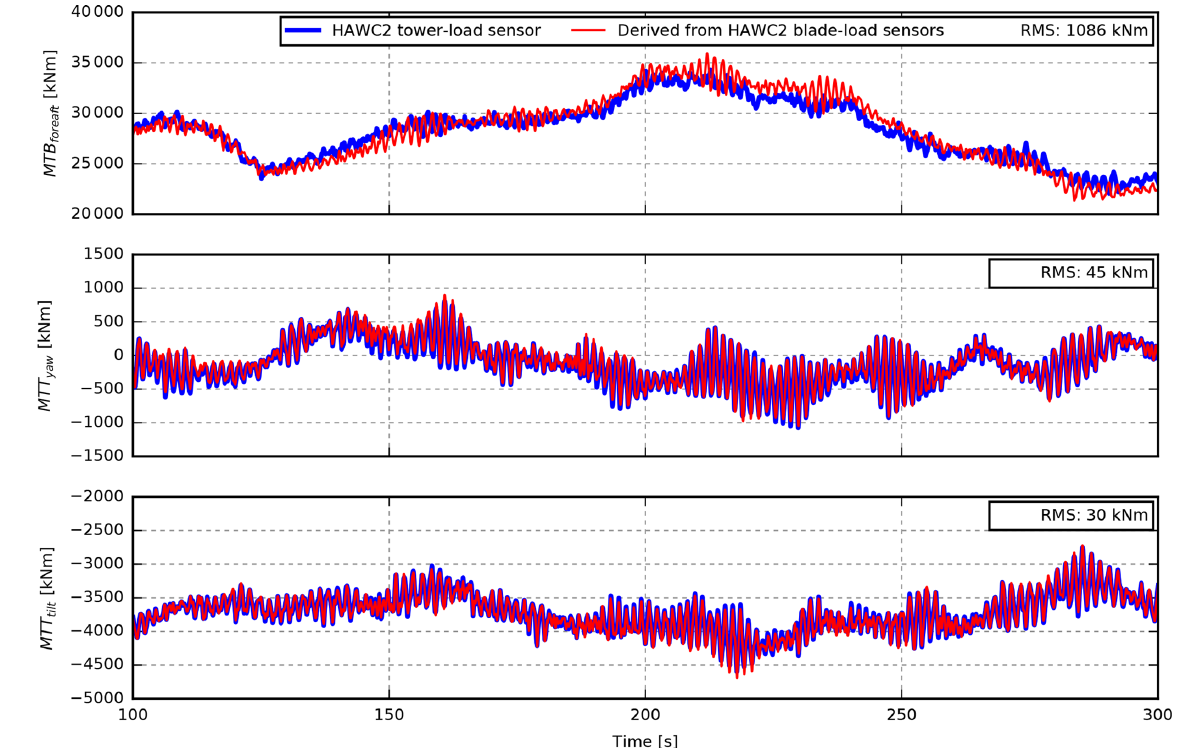
Figure 5. Comparison of the HAWC2 simulated tower loads and the estimated tower loads, which are derived from the HAWC2 simulated blade-root load sensors and calibrated for 8ms − 1